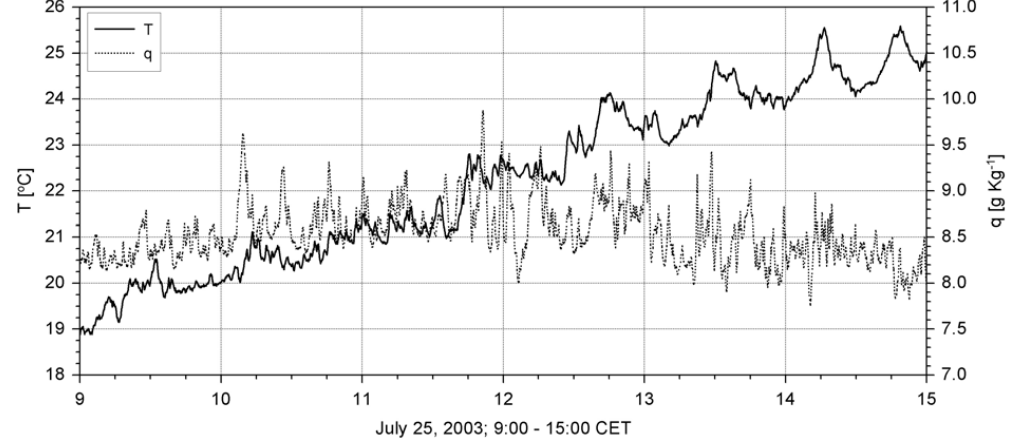
Fig. 2. Air temperature T ( ◦ C) and specific humidity q (g H /kg Air ) from psychrometer at 37m height for 25 July 2003, 09:00–15:00CET.